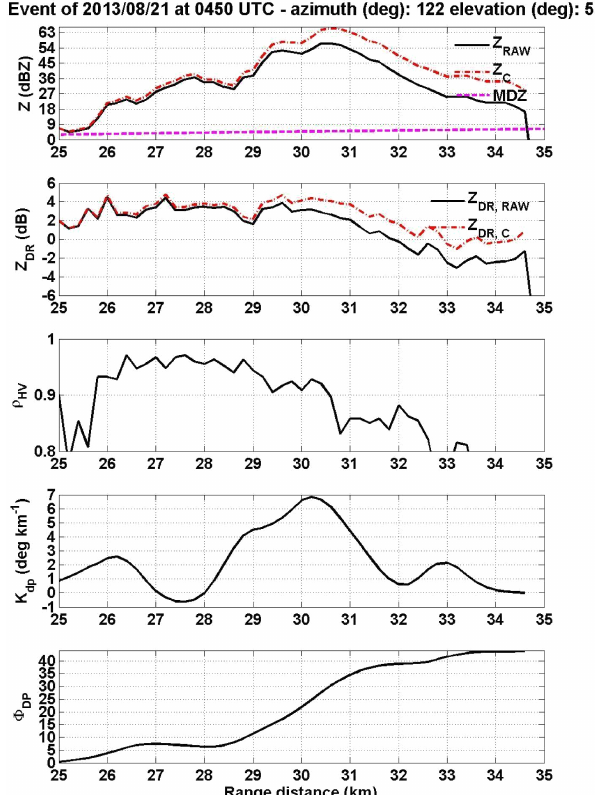
Figure 15. Range plots of the polarimetric radar measurements Z H , Z DR , ρ HV , K DP and (cid:56) DP taken at 122 ◦ of azimuth and 3 ◦ of an- tenna elevation on 21 August 2013 at 04:50UTC. The two upper panels also show the attenuation-corrected reflectivity and differen- tial reflectivity. The minimum detectable Z H (MDZ) is also plotted on the upper panel.